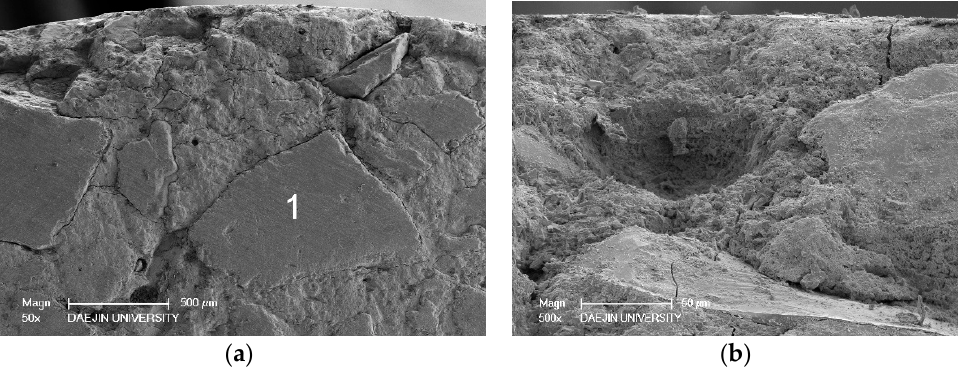
Figure 14. SEM images of 12% OPC mortar after sulfate attack ( a ) Cracks are more visible in the peripheral zone compared to the inner zone, visible crack on the outer side of aggregate 1 compared to its inner side. ( b ) A crack originating from the outer surface moving toward the inner core.